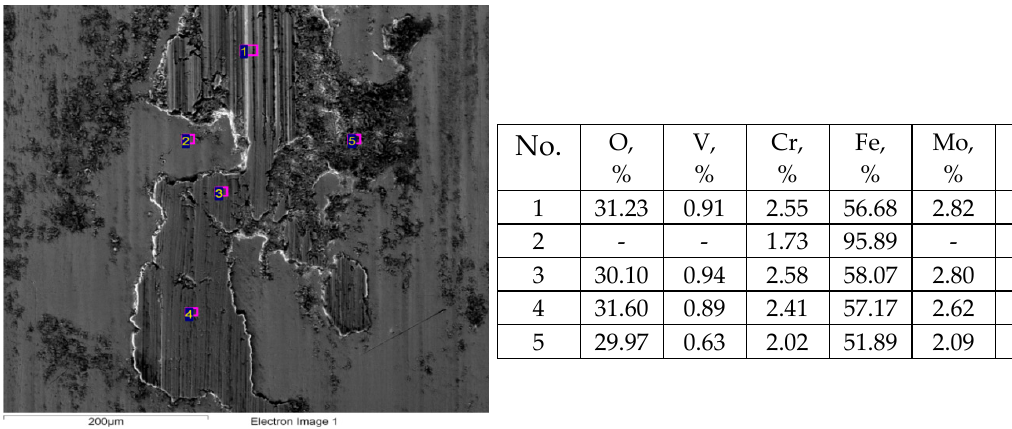
Figure 12. EDS analysis of the ball co-acted with worn lapped disc L after test A; s = 0.2 mm, P = 45 N, f = 20 Hz.